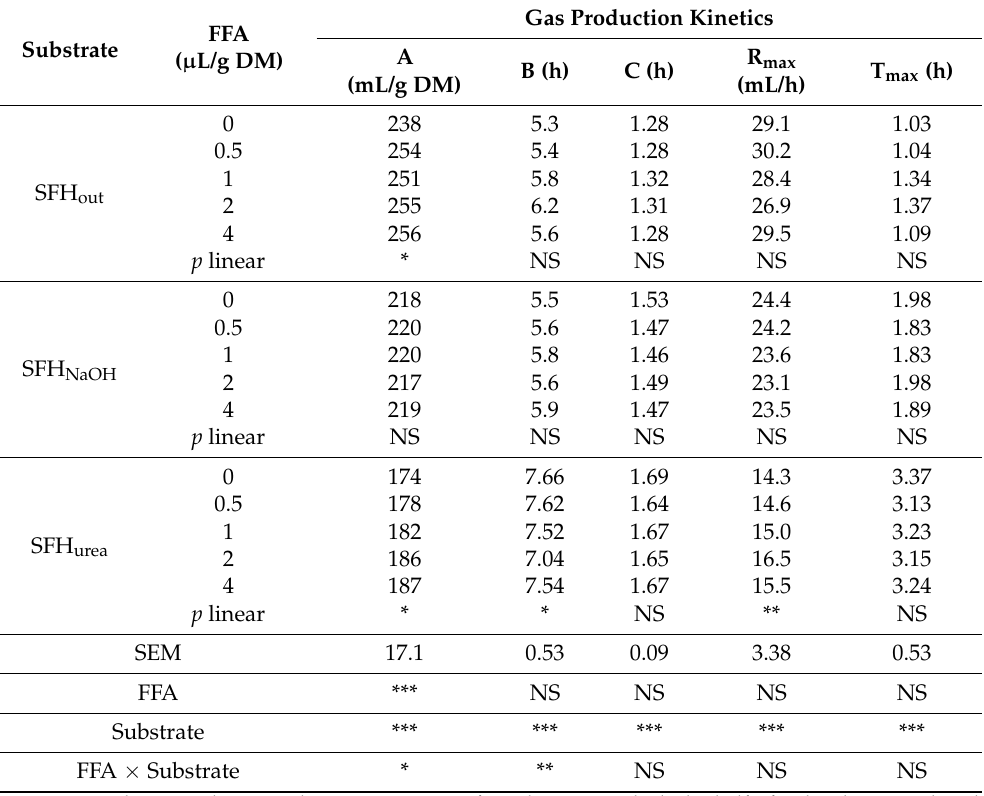
Table 3. Effects of FFA supplemented to pretreated SFH (SFH out , SFH NaOH , SFH urea ) on the kinetics of the in vitro gas